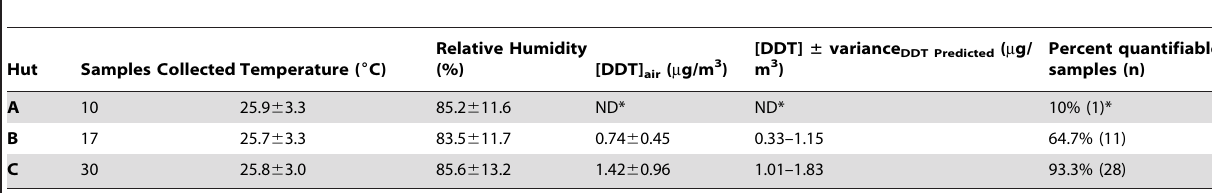
*One sample analyzed with 1.22 m g/m 3 DDT; a labeling error is suspected.